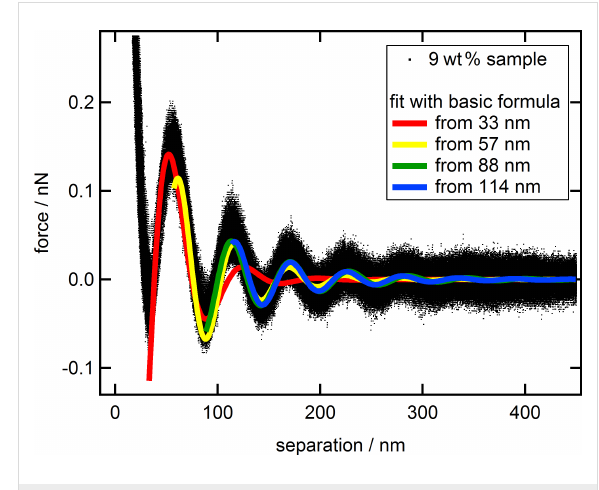
Figure 2: Combined force data of the 9 wt % suspension (black dots) together with fits based on Equation 1 from different starting points: 33 nm (red), 57 nm (yellow), 88 nm (green) and 114 nm